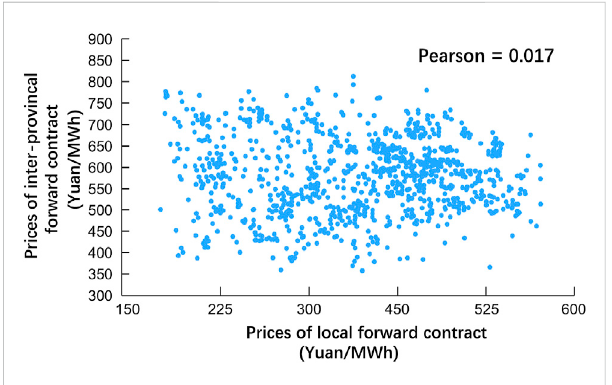
FIGURE 2 Correlation analysis of simulated prices in local and inter- provincial forward contracts.